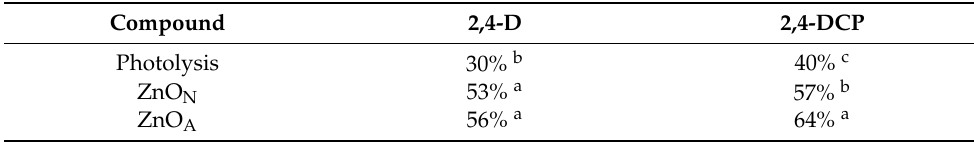
All values are mean ± standard deviation of three determinations. Different letters in each column indicate significant statistical differences between treatments ( p <